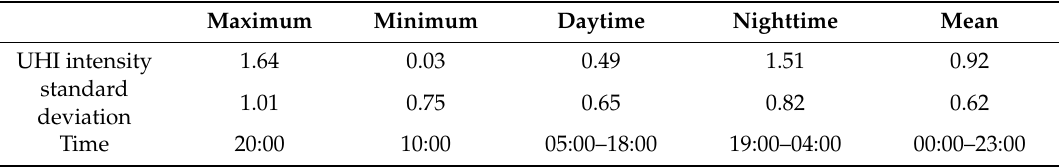
Table 4. The mean hourly UHI intensity ( ◦ C) of the study area for the period of August 1–31,